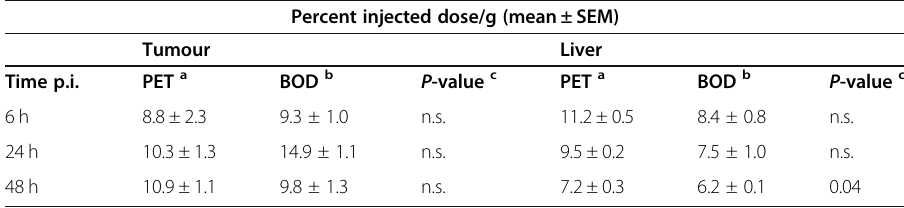
Table 2 Comparison of the tumour and liver uptake of radioimmunoconjugates (RICs) estimated by region of interest (ROI) analysis of PET images and biodistribution (BOD) studies Percent injected dose/g (mean ± SEM) Tumour Liver Time p.i. PET a BOD b P -value